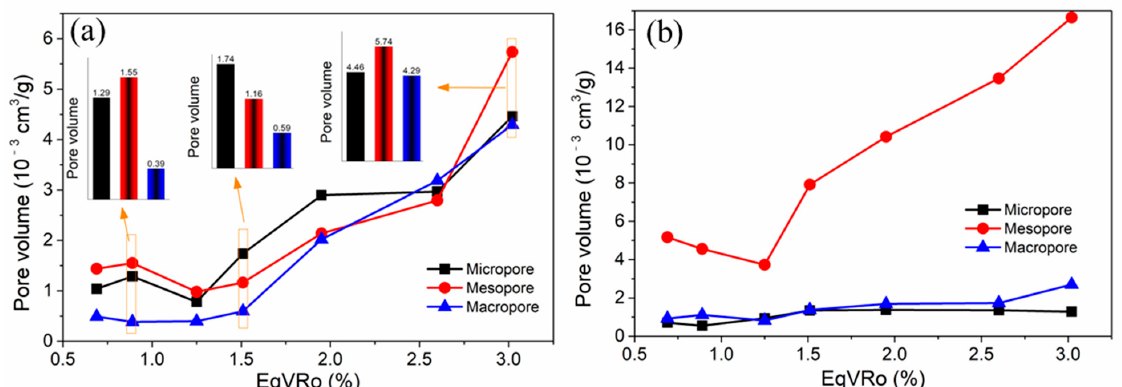
Figure 10. Changes of pore volume of shale during ( a ) open system and ( b ) semi-closed system pyrolysis experiments. Data of semi-closed pyrolysis are cited from Fang et al. [21].